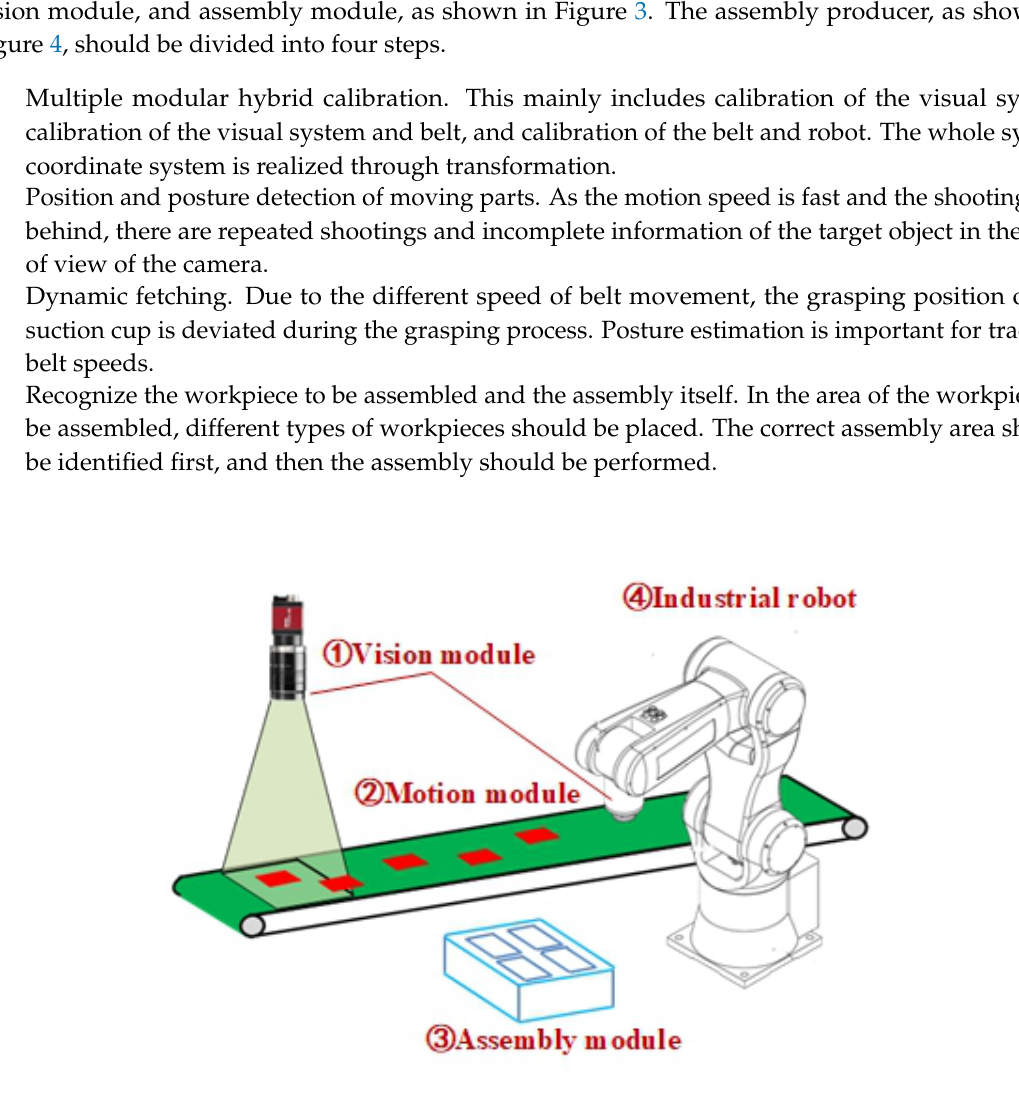
Figure 3. System